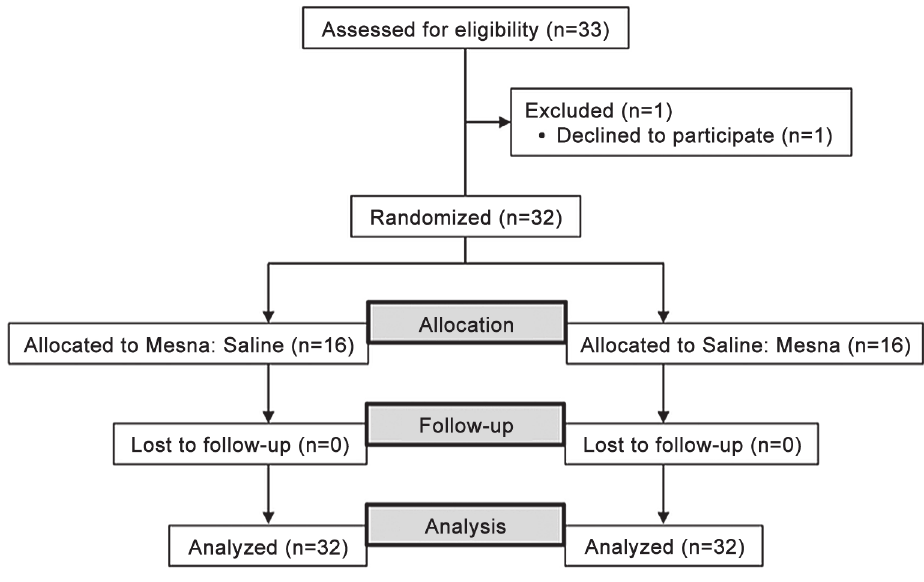
Fig 1. Flow of patient